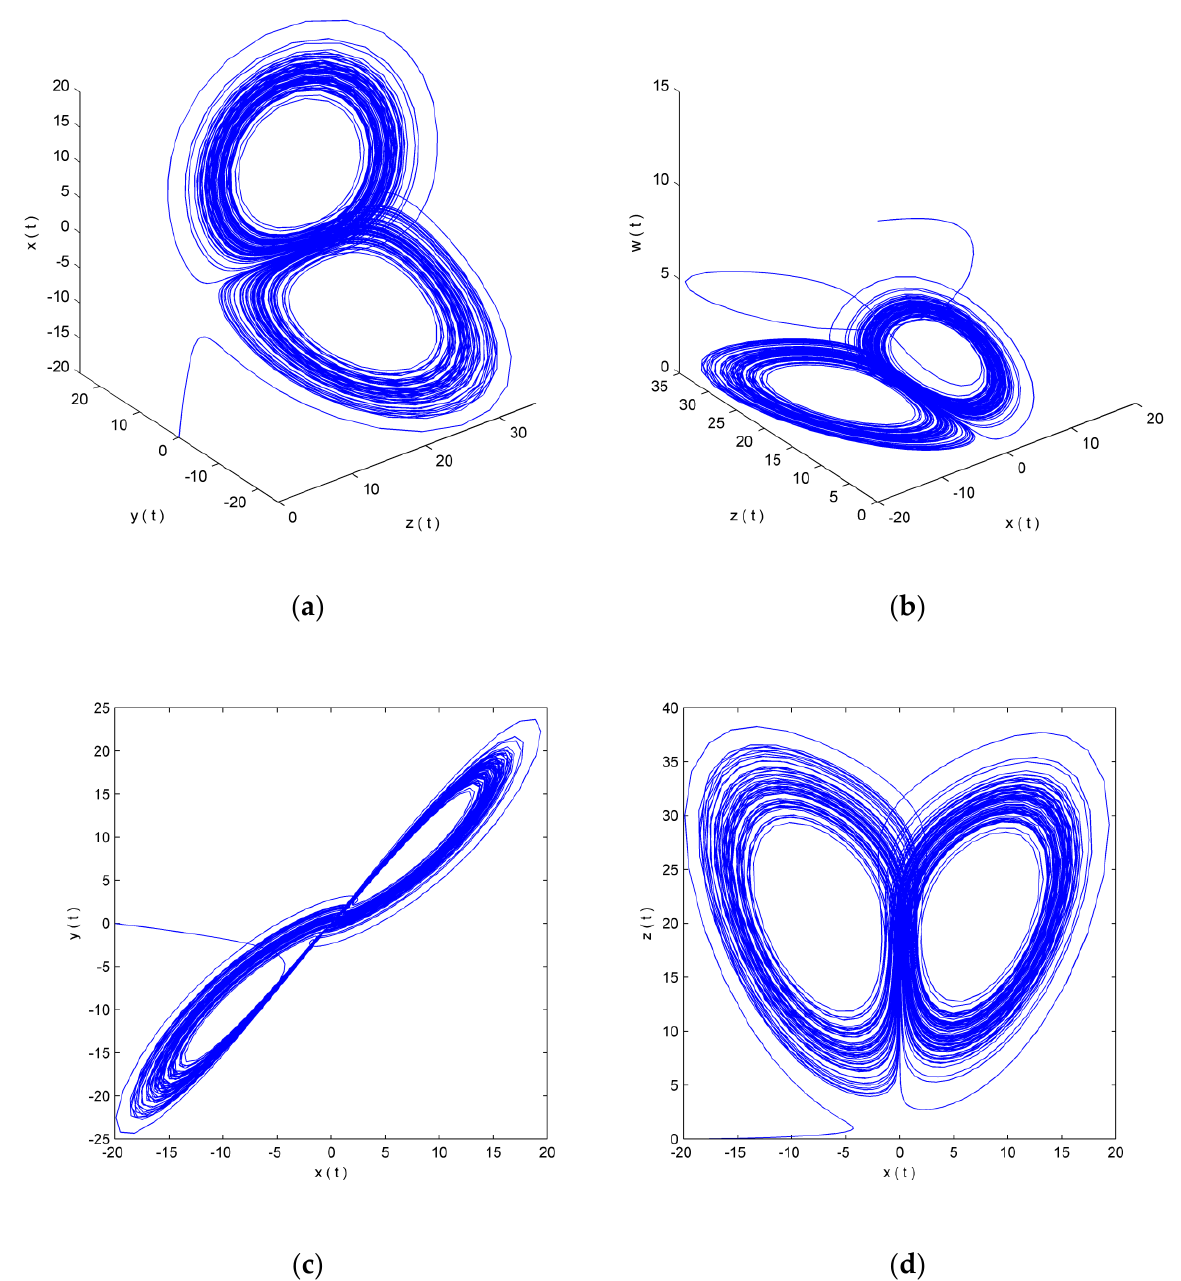
Figure 3. Phase diagram of a four-dimensional chaotic attractor. ( a ) z-y-x diagram; ( b ) x-z - w diagram; ( c ) x-y plane phase diagram; ( d ) x-z plane phase diagram.